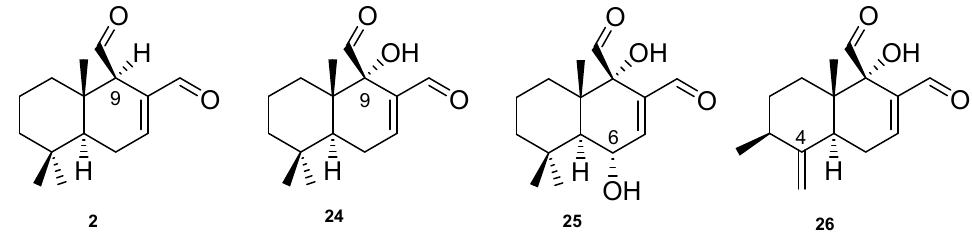
Figure 7. Cytotoxic drimanes and coloratanes from Warburgia ugandensis against KB, MV4-11, THP- 1 leukemia, Sk-Mel29 melanoma, and LN-229 glioblastoma cells [52,53].